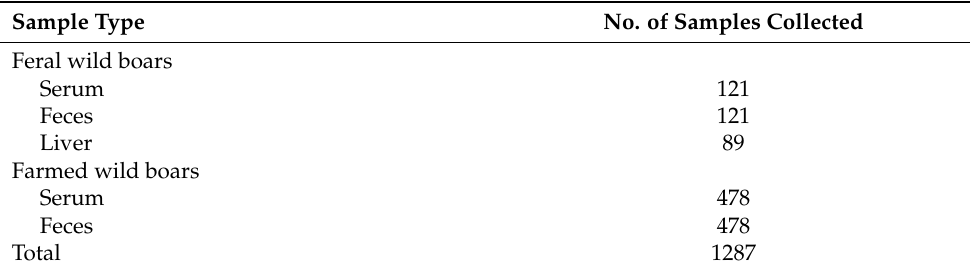
Table 1. Number of samples collected in this